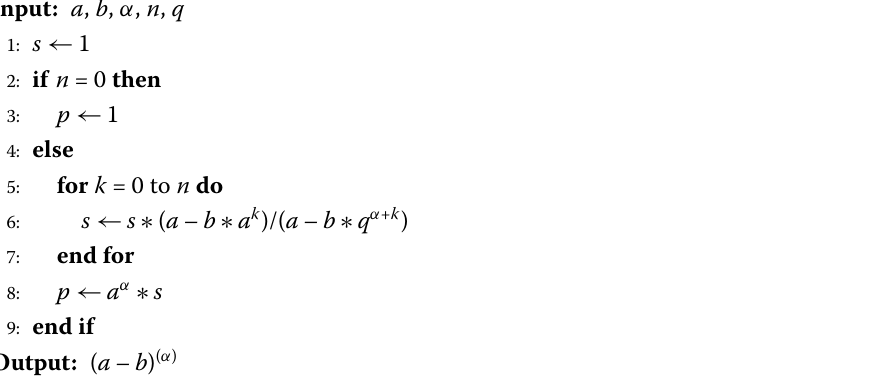
Algorithm 1 The proposed method for calculating ( a – b ) ( α ) q